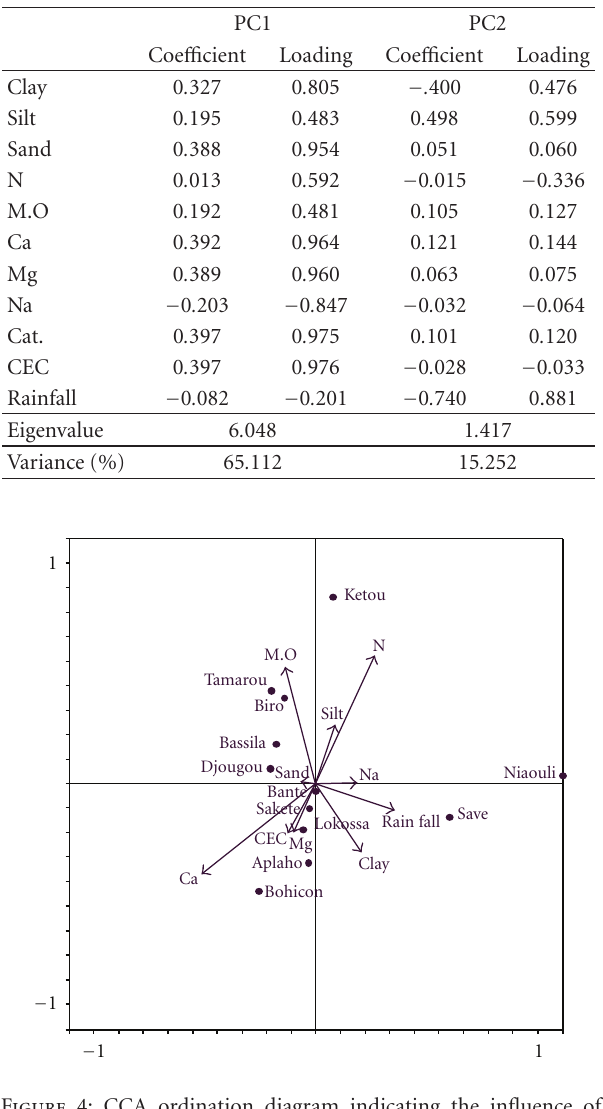
Table 3: Results from principal component analysis (PCA) of environmental data.